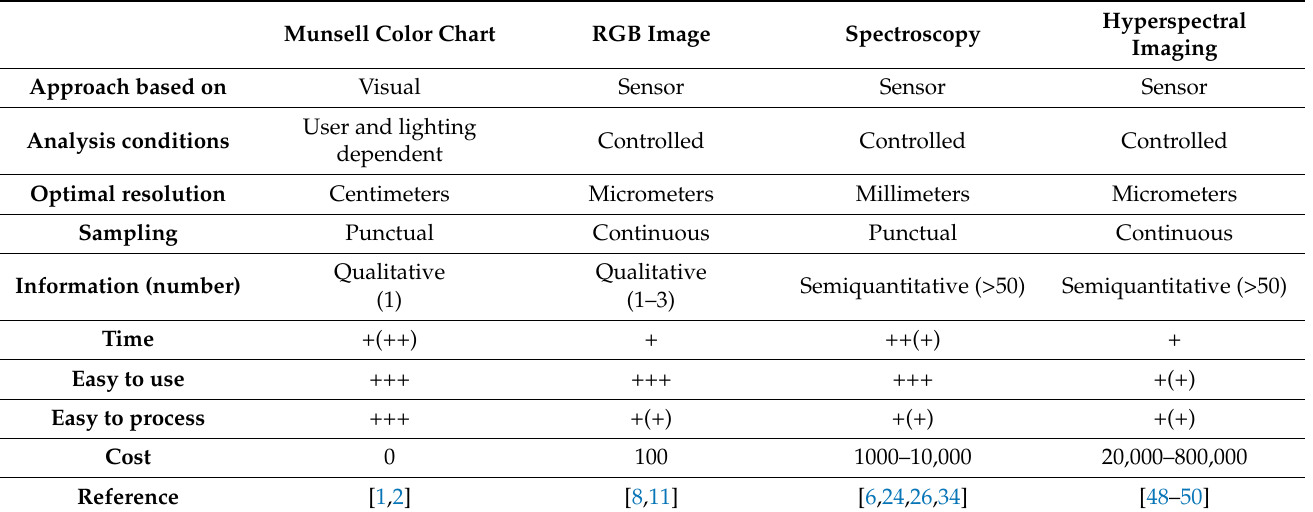
Table 1. Comparison of the technique for the sediment core color analysis.